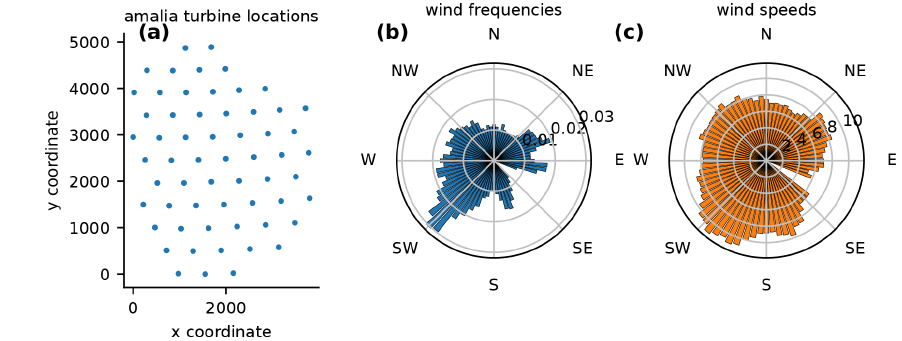
Figure 11. The Princess Amalia Wind Farm definition; shown in (a)–(c) are the wind farm layout, the wind direction probabilities, and the directionally averaged wind speeds, respectively. The dots representing the turbine locations are to scale with the turbine rotor diameter.